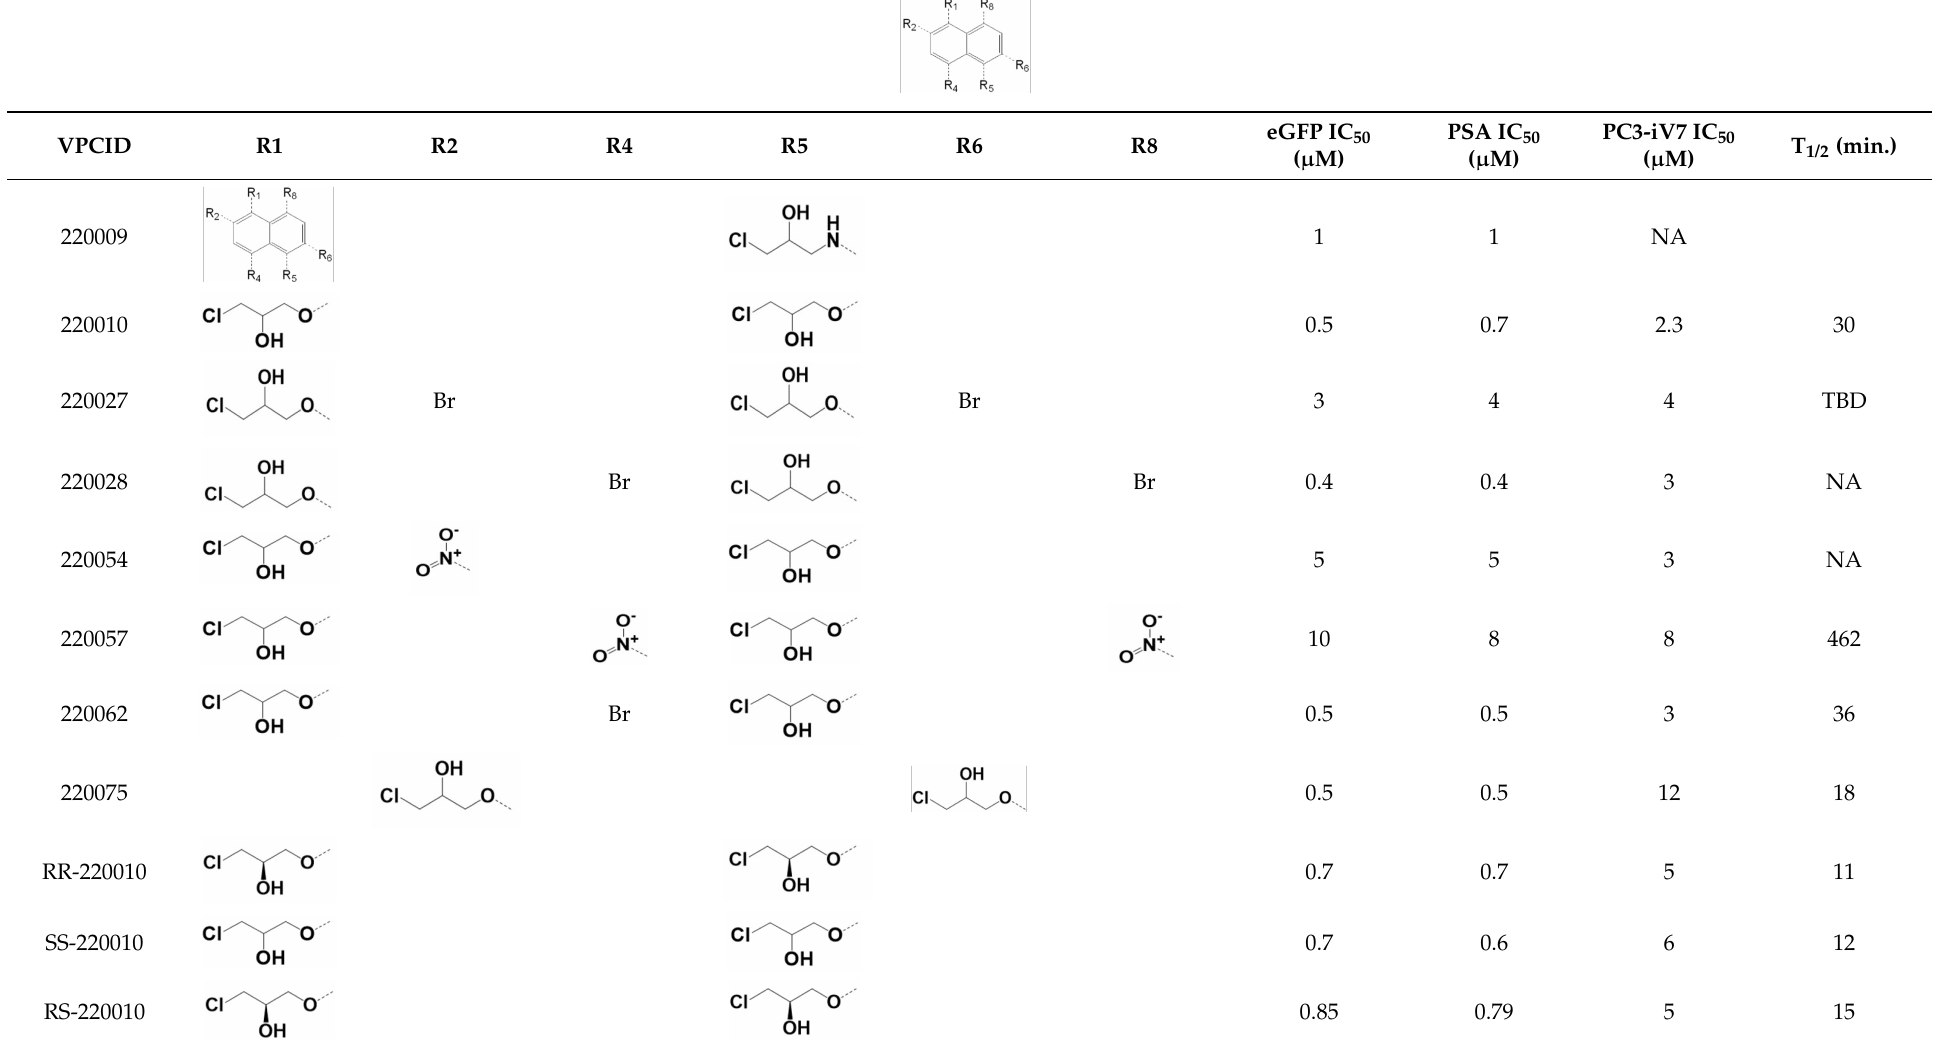
Table 1. Efficacy and microsomal stability of the active AR-NTD